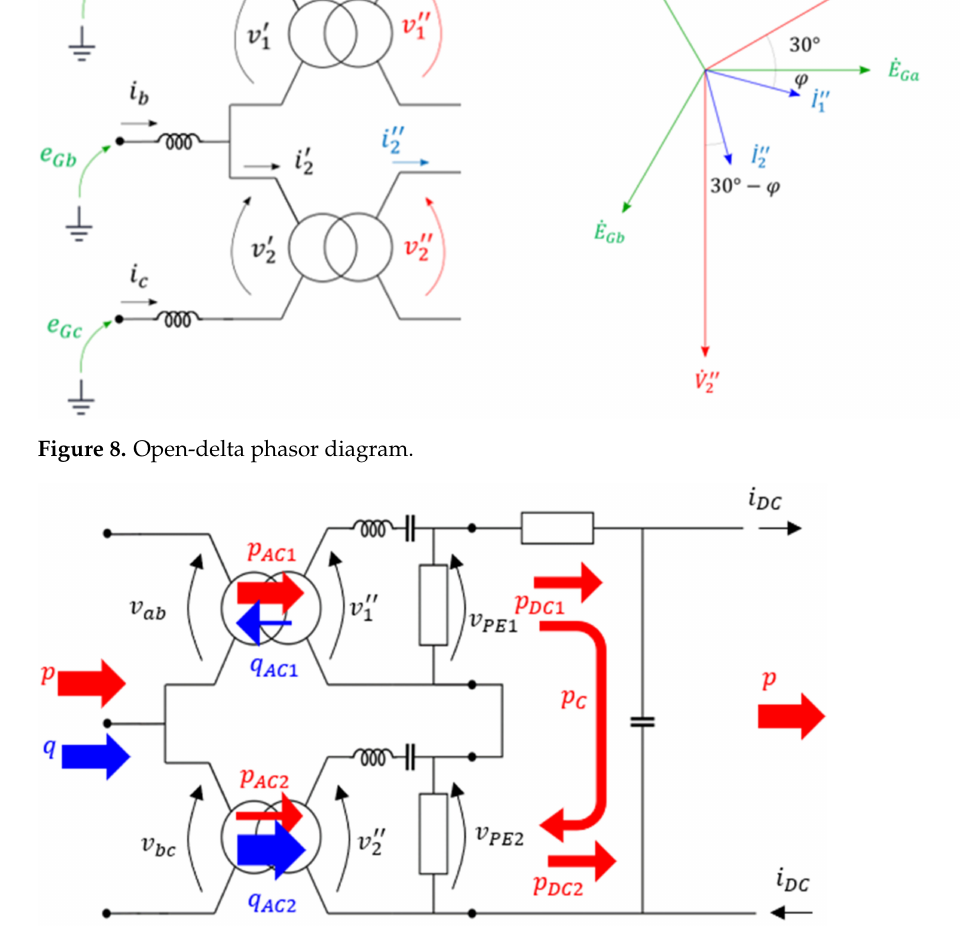
Figure 9. Series open-delta CLSC power